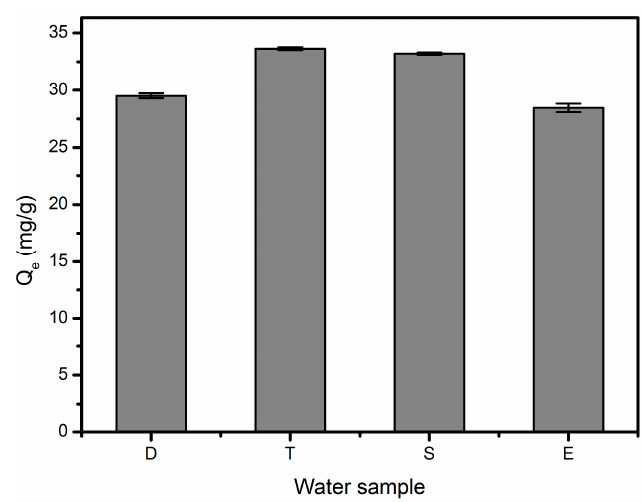
Figure 9. The adsorption of BPA on Mag-PVP in different water samples. D, T, S, and E represent deionized water, tap water, surface water, and the effluent water in sewage treatment plants, respectively (BPA concentration = 10 mg/L; adsorbent dosage = 0.2 g/L; shaking time = 4 h). Error bars represent standard deviation values from three replicates. Table 2. The main properties of the water samples.